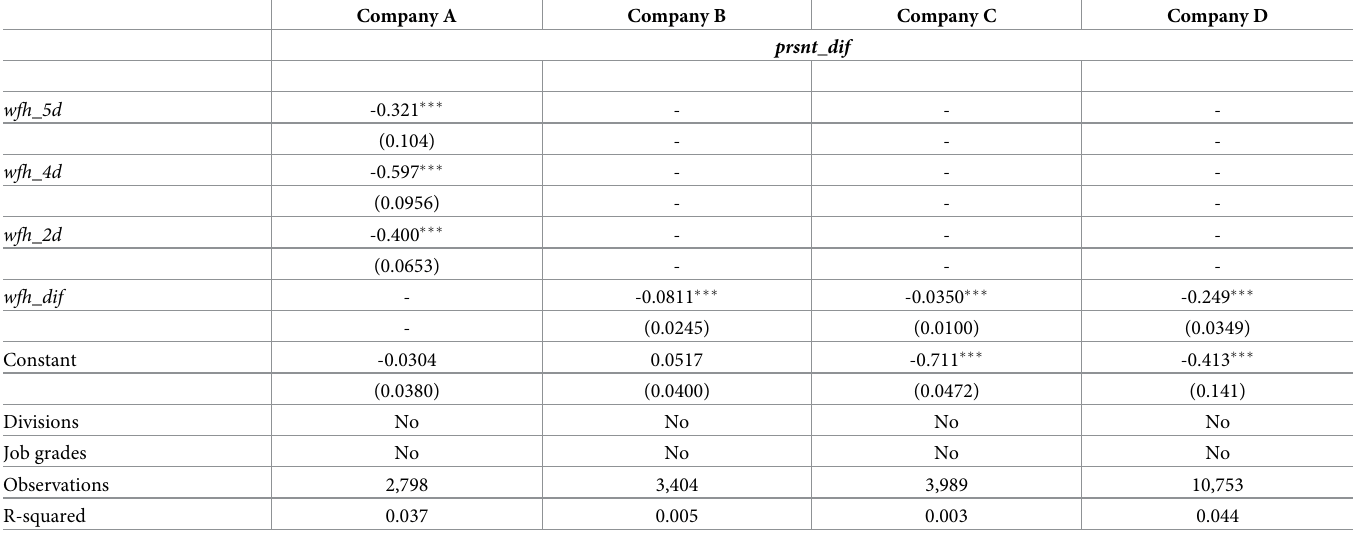
Table 2. Regression of productivity changes on